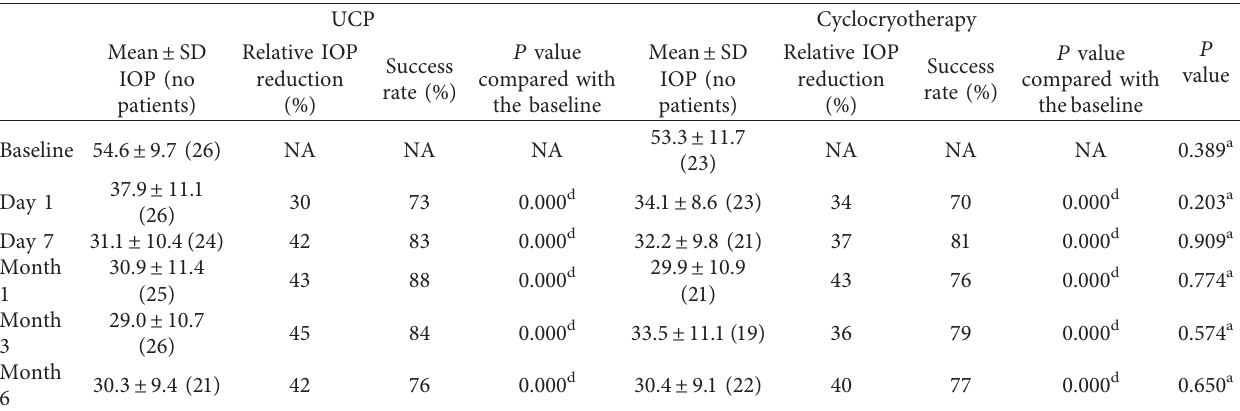
Table 2: Intraocular pressure at baseline and during follow-up in the patients. UCP Cyclocryotherapy